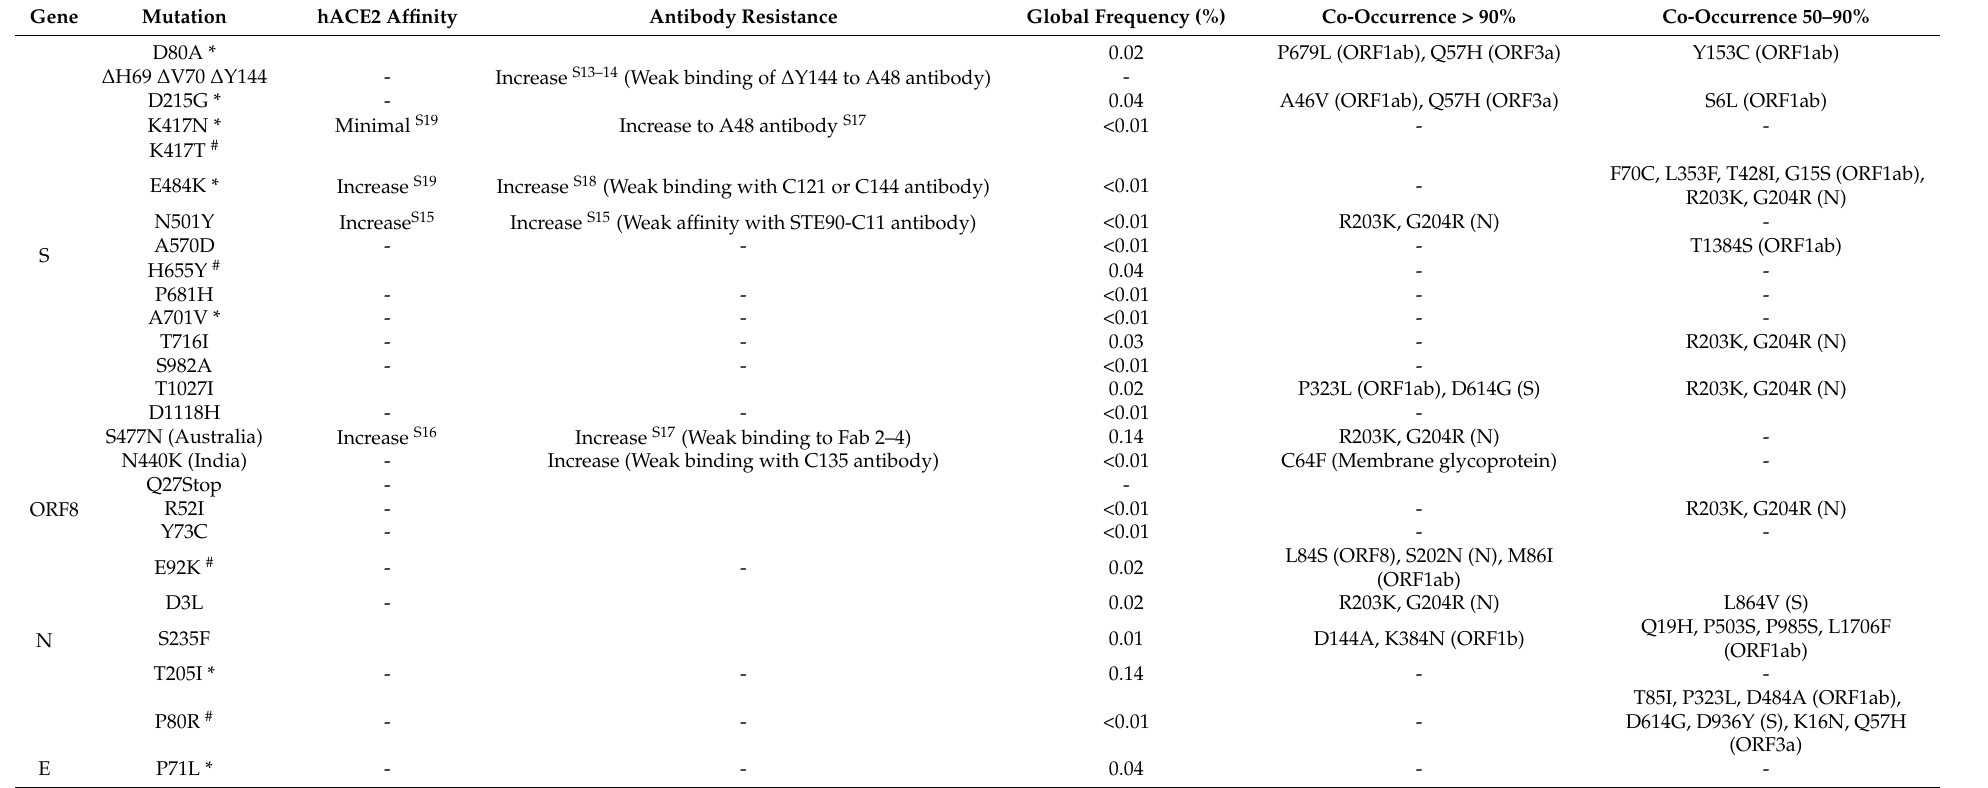
Table 1. Notable non-synonymous mutations and deletions ( ∆ ) in S, envelope (E), ORF8, nucleocapsid (N) proteins of SARS-CoV-2 501Y.V1, 501Y.V2 (*) and P.1 ( # ) variants. Co-occurring mutations other than D614G (S protein) and P323L (ORF1ab) are shown here. Protein names are shown in parenthesis. Table adapted from Portelli et al. and the Public Health England report [16,17]. References for modulation in hACE2 affinity or antibody resistance (shown as superscripts) are provided in supplementary